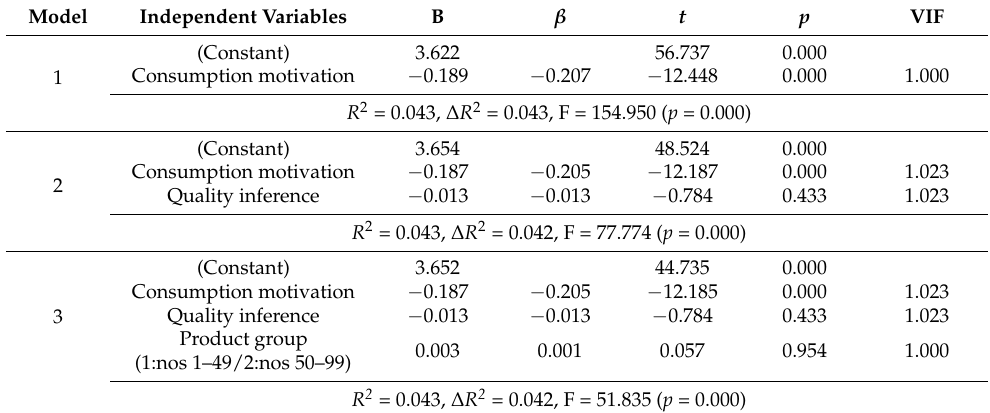
Table 11. General consumers: results of hierarchical multiple regression analysis to identify factors influencing purchase